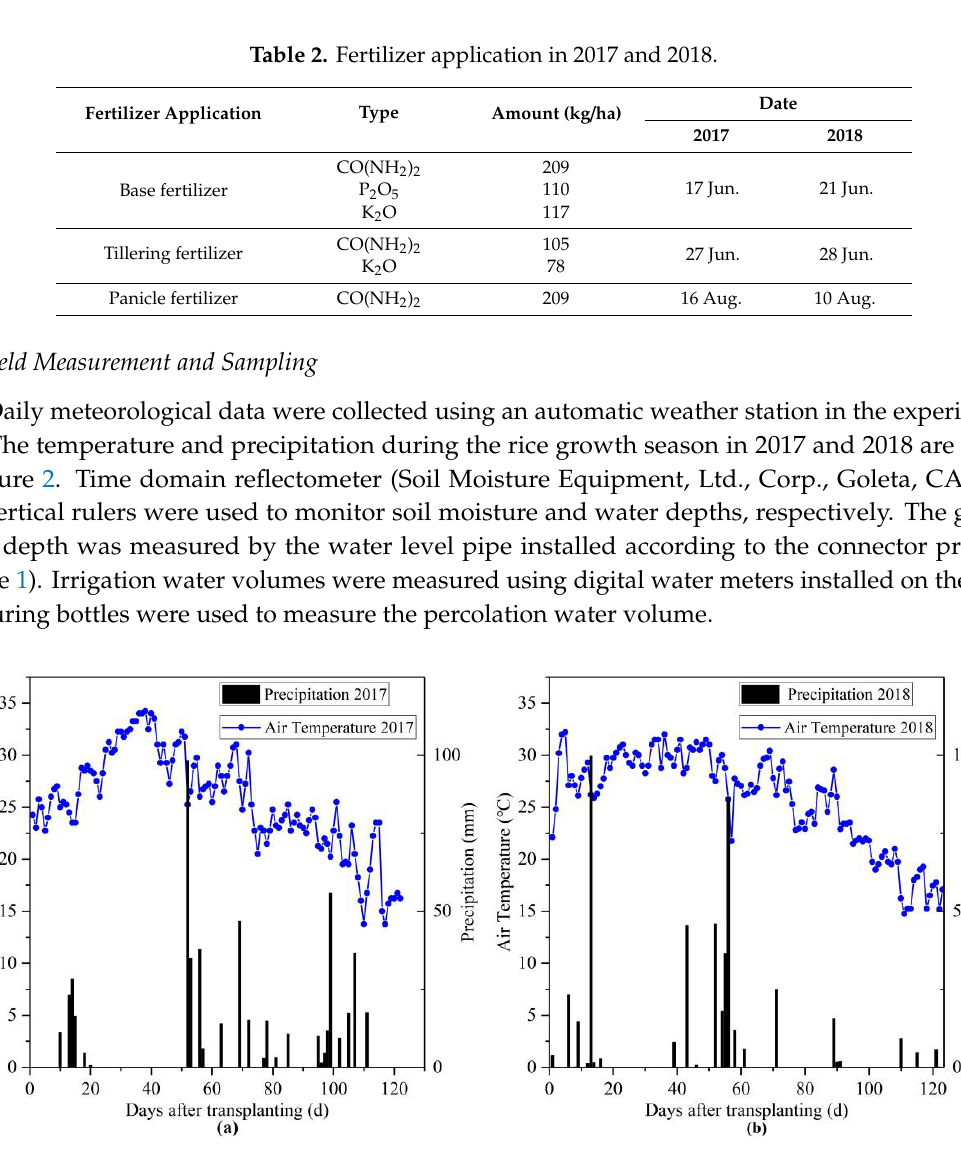
Figure 2. Daily average temperature and precipitation during the rice growth season in ( a ) 2017 and and ( b ) ( b ) 2018.